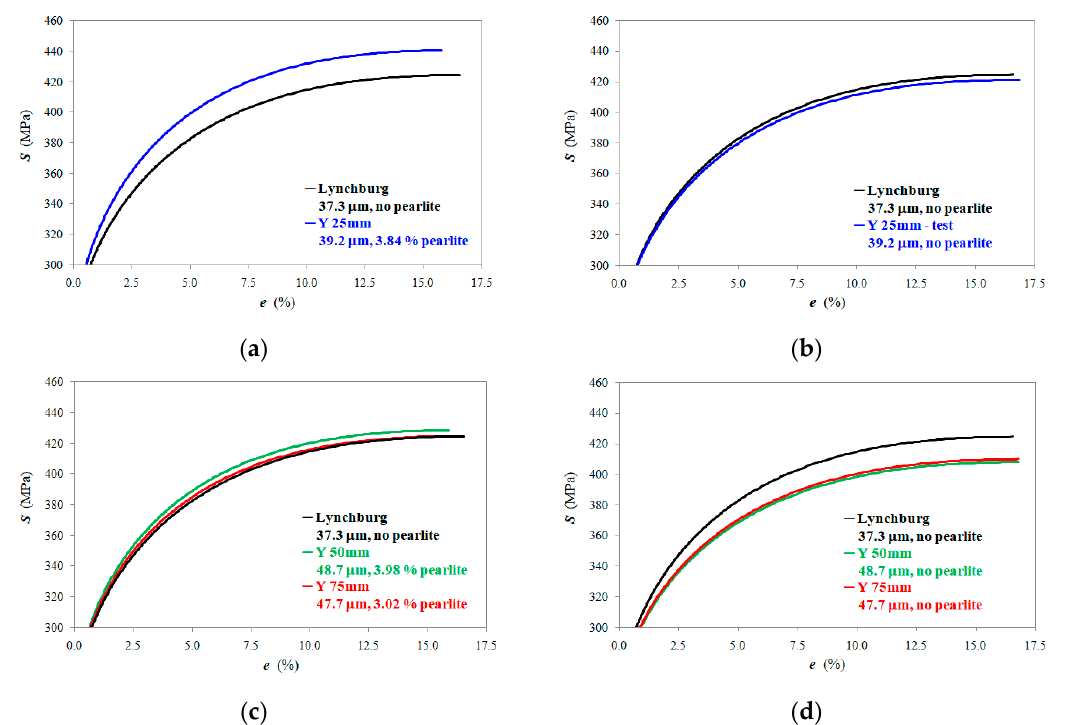
Figure 6. Engineering stress–strain curves (up to an ultimate tensile stress of R m ): ( a ) Lynchburg and Y 25 mm moulds and ( b ) ferrite contribution to flow curves only; ( c ) Lynchburg, Y 50 mm and Y 75 mm moulds; ( d ) ferrite contribution to flow curves only.